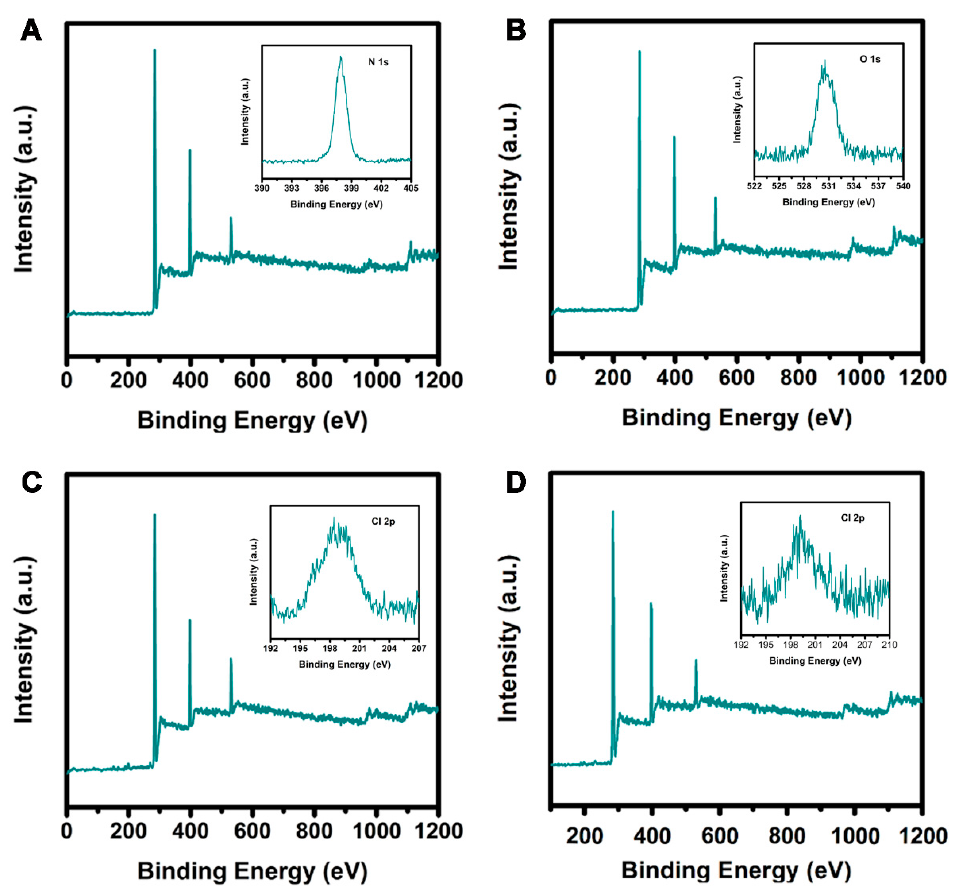
Figure 6. XPS survey scans, (insert in A ) N 1s spectrum, (insert in B ) O 1s spectrum, and (insert in C and D ) Cl 2p spectrum of ( A ) PAN, ( B ) PAN/GO, ( C ) PAN/DCDMH, and ( D ) PAN/GO/DCDMH. C , D ) Cl 2p spectrum of ( A ) PAN, ( B ) PAN/GO, ( C ) PAN/DCDMH, and ( D )